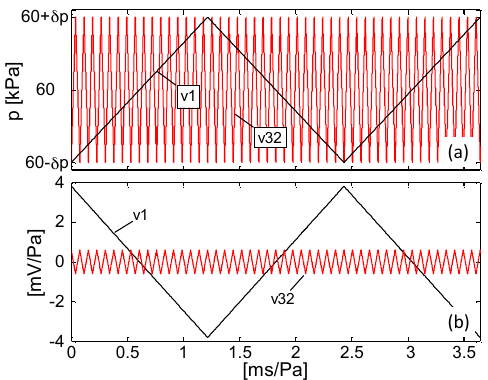
Figure 19. Calculated output signal ( b ) of a sensor pre-compressed at 60 kPa and subjected to a pressure variation of ± δ p which is applied with a deformation speed of v 1 or v 32 ( a ).